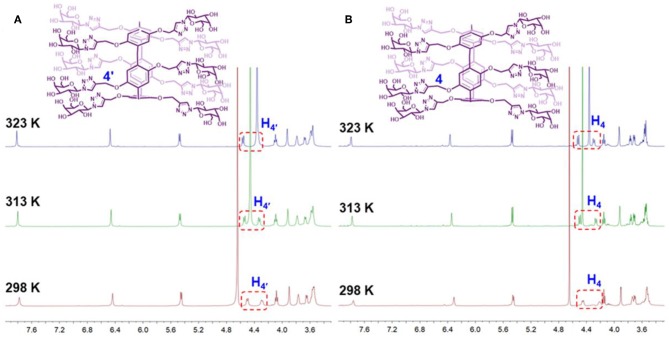
Dynamic 1H NMR spectra of (A) (Sp-D)-GP5 (4 mM in D2O) and (B) (Rp-D)-GP5 (4 mM in D2O).